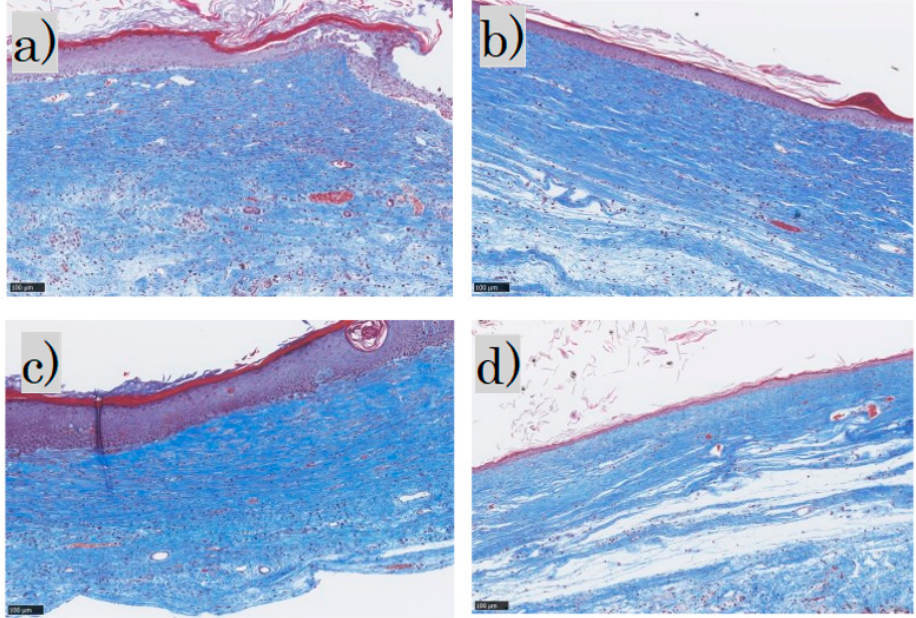
Figure 4. Masson trichrome staining: ( a ) control group; ( b ) FB group; ( c ) SS group; ( d ) LS group. FB, fibroblasts; SS, short-term sphere-forming culture; LS, long-term sphere culture (scale bar 100 µm). Collagenized tissue is stained in blue while other tissues are stained red.